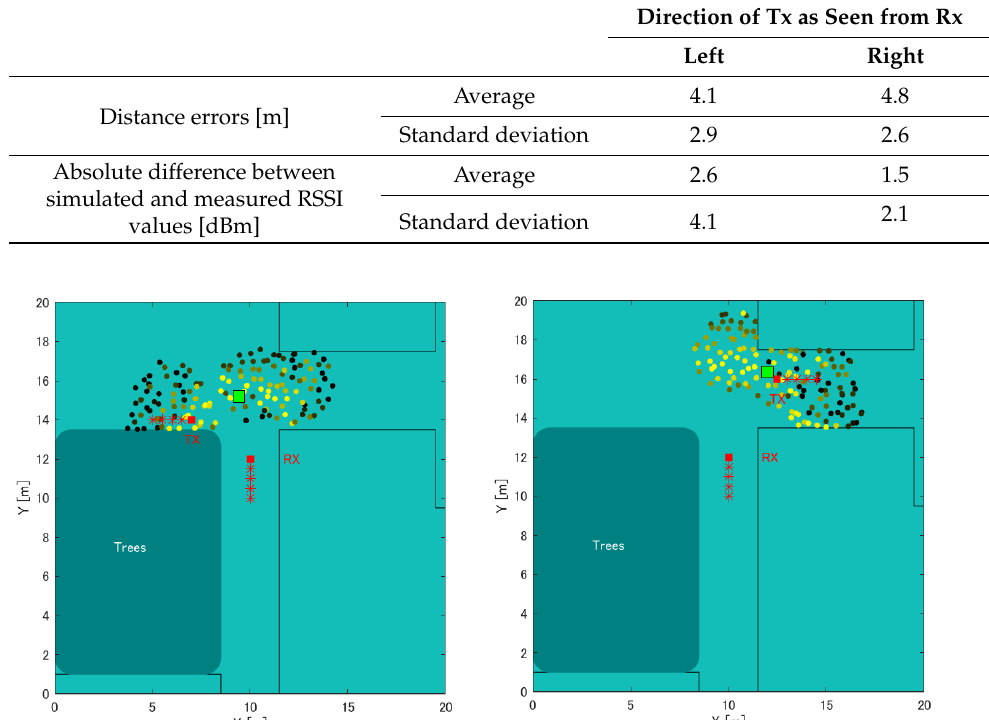
Table 3. Position estimation error results of the actual measurement in the case of Tx moving on a T-shape road.